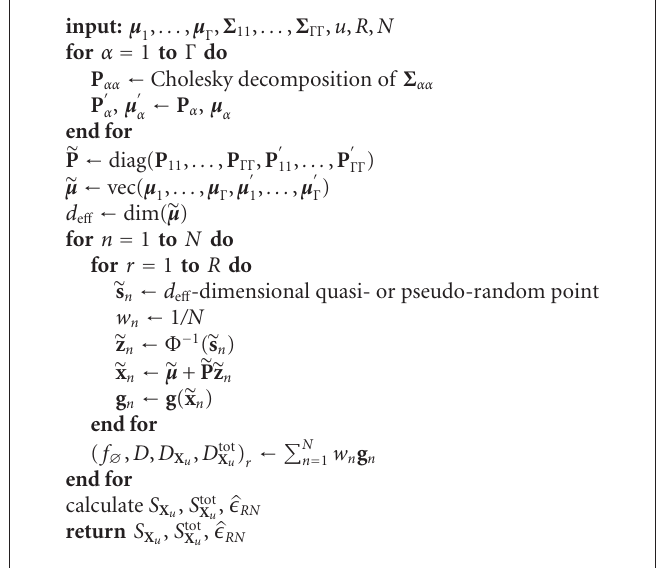
Algorithm 1: The calculation of sensitivity indices using Monte Carlo quadrature.